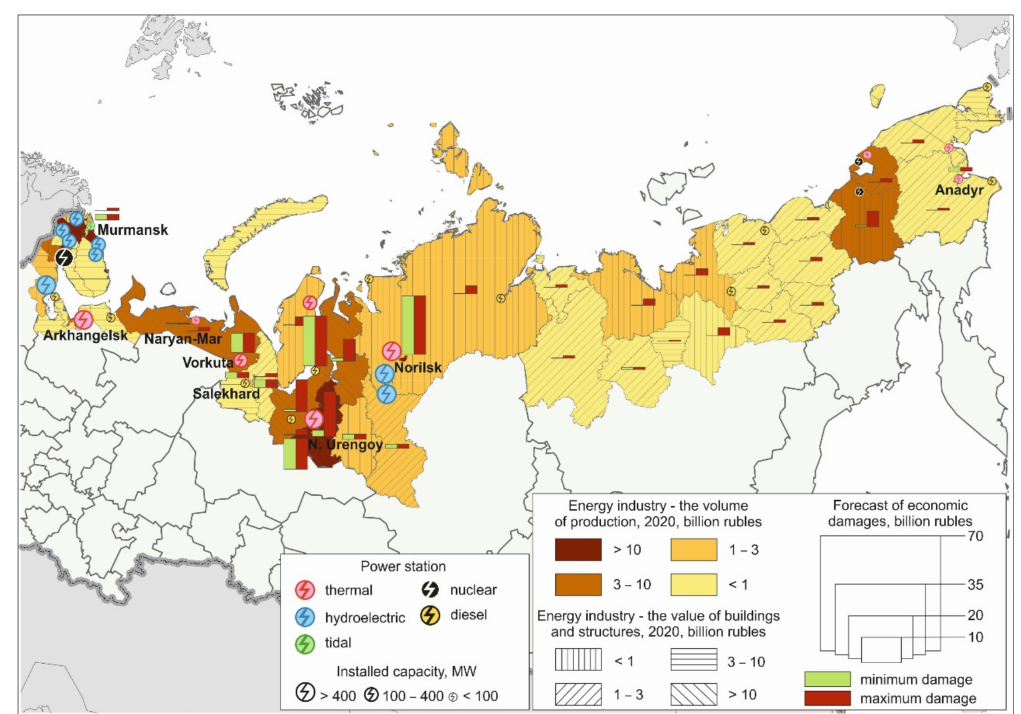
Figure 2. The main characteristics of the energy industry of the AZRF. Source: compiled by the authors based on their own calculations, Rosstat data [42] and the official heat supply schemes for regions and